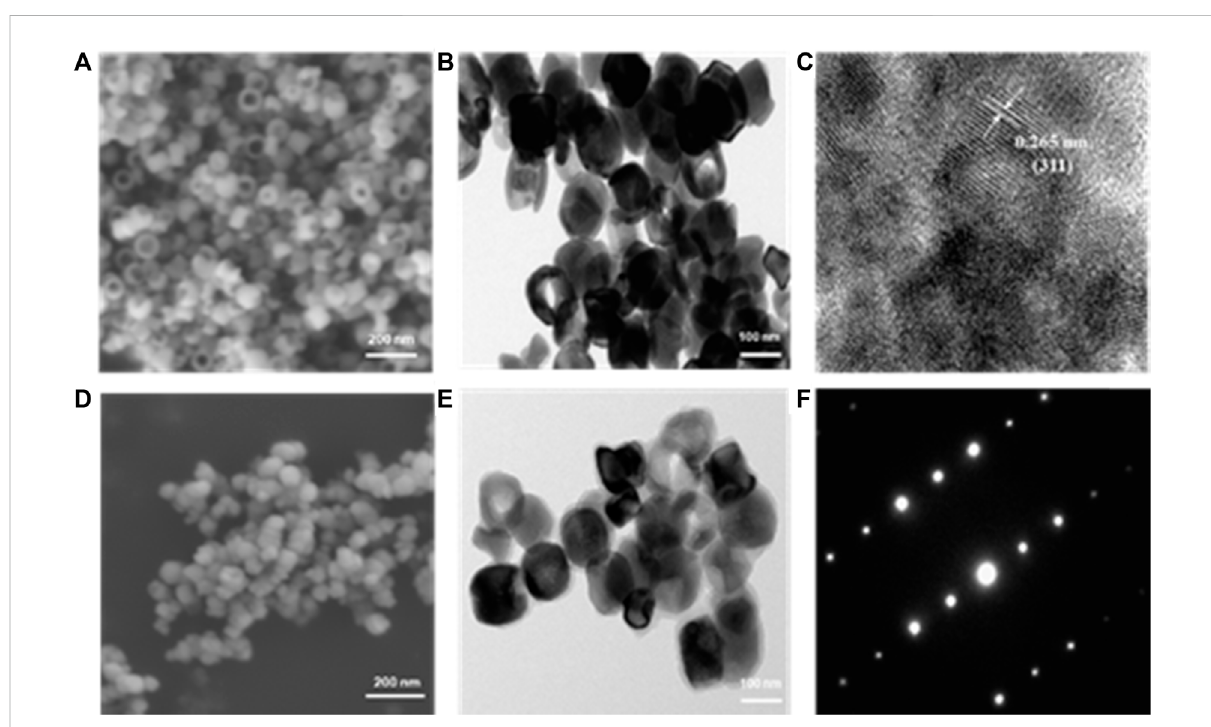
FIGURE 1 Morphologyimagesofobtainedsamples.SEM (A) andTEM (B) imagesofnakednanoringFe 3 O 4 . (C) High-resolutionTEMimagerecordedonFe and the interlayer spacings matched with that of magnetite. SEM (D) and TEM (E) images of HA-coated nanoring Fe 3 O 4 and (F) corresponding fast Fourier transforms electron diffraction